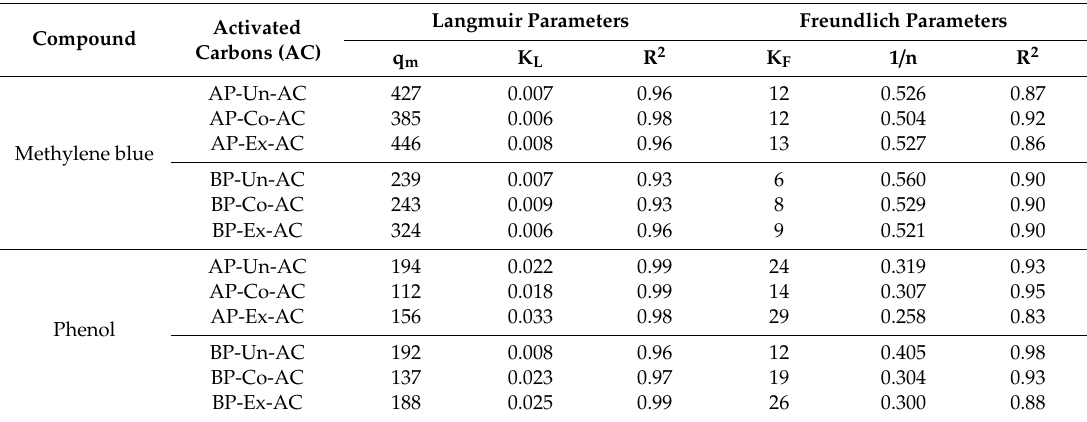
Table 3. Langmuir and Freundlich parameters for the adsorption of methylene blue and phenol by the activated carbons obtained in this